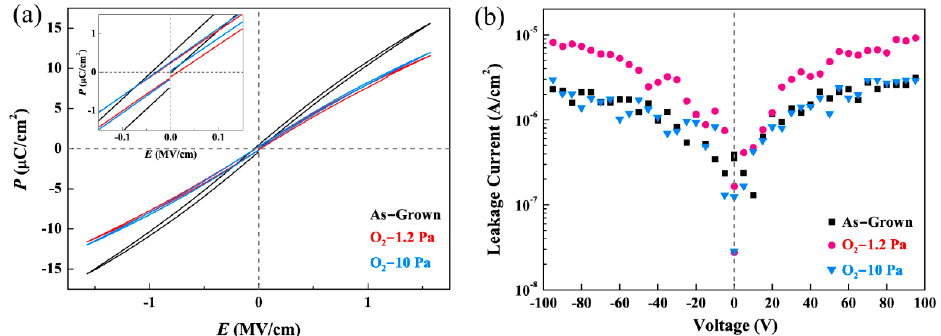
Figure 2. The room temperature P-E hysteresis loops (a) and leakage current density–voltage curves (b) of the as-grown and annealed BZT films (in 1.2 Pa and 10 Pa O 2 ).